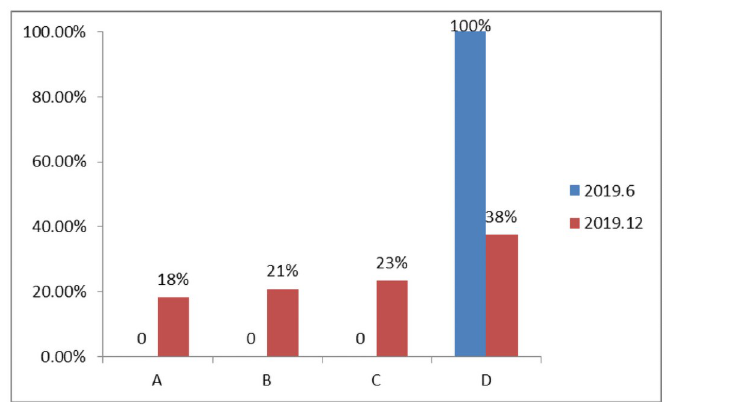
Fig 6. Ratio comparison of role performance (2019.12).